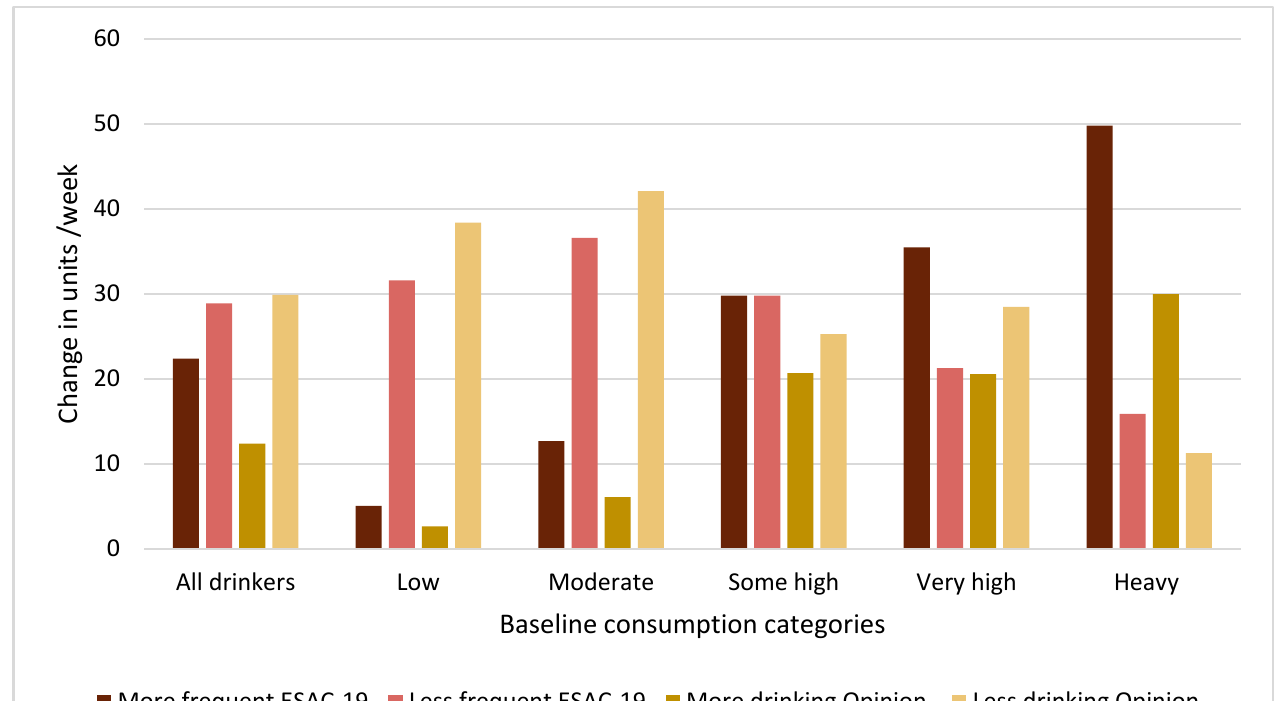
Figure 1. Self-reported changes in drinking behavior by baseline consumption categories and survey. Note: the baseline consumption categories are based on percentiles. Low = < 25th percentile, moderate = between the 25th and 50th percentiles, some high = between the 50th and 75th percentiles, very high = between the 75th and 90th percentiles, and heavy = > 90th percentile; more frequent = reporting ‘much more often’ or ‘slightly more often’ on change in drinking frequency in the past month; less frequent = reporting ‘much less often’ or ‘slightly less often’ on change in drinking frequency in the past month; more drinking = reporting ‘much more’ or ‘slightly more’ on change in alcohol consumption during the pandemic; less drinking = reporting ‘much less’ or ‘slightly less’ on change in alcohol consumption during the pandemic.